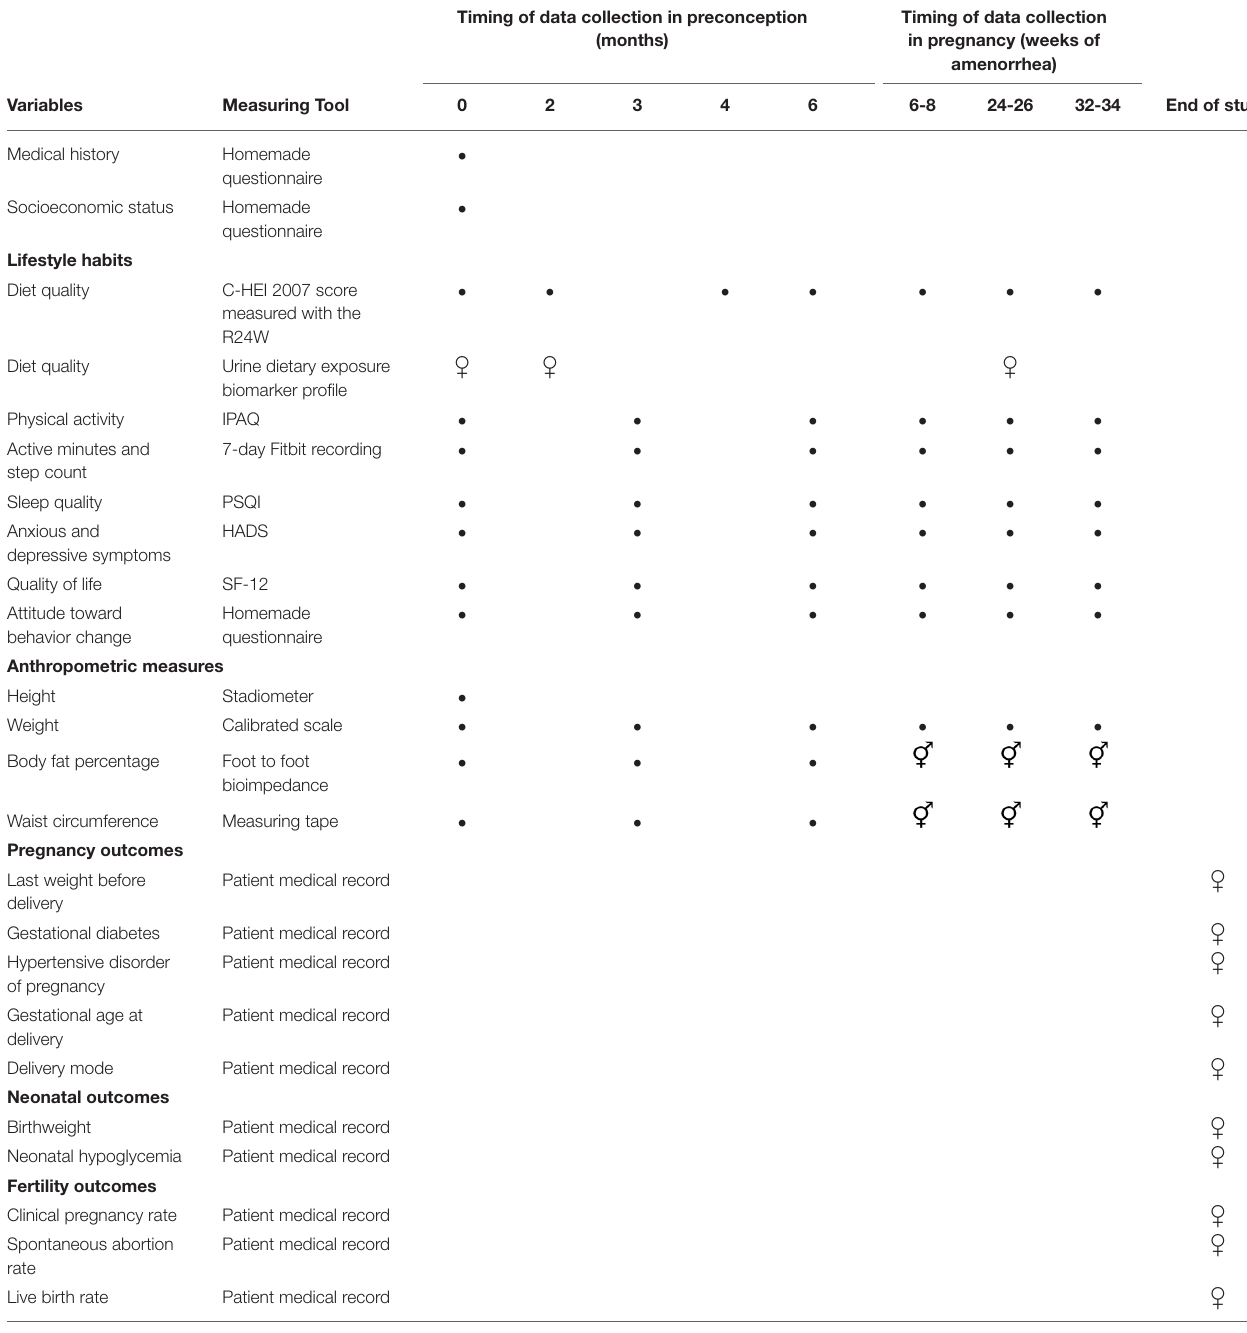
TABLE 1 | Summary of study